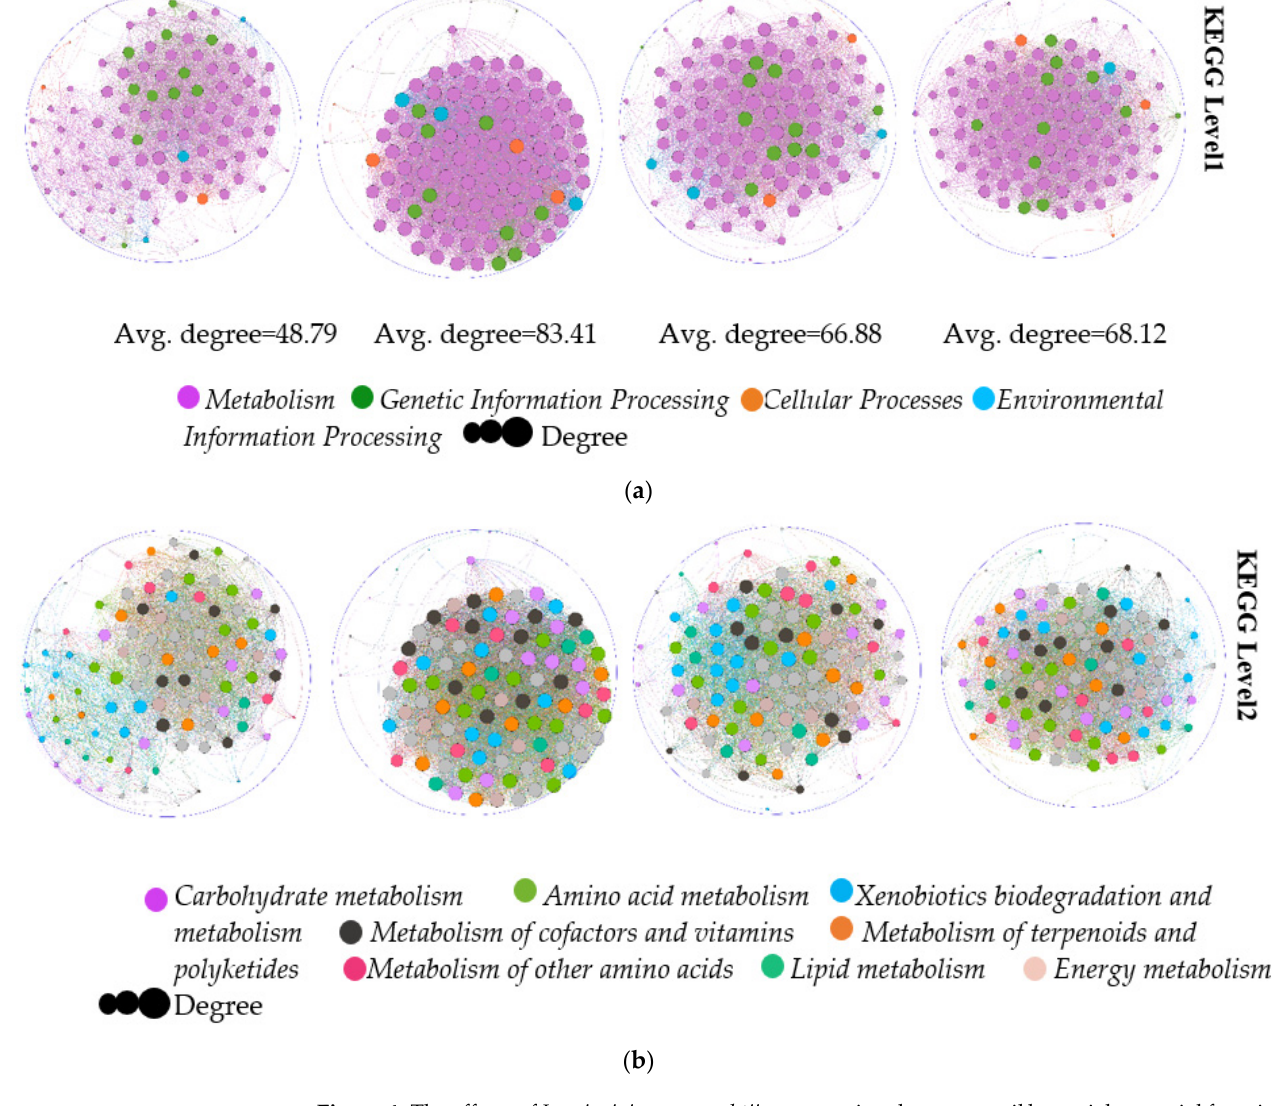
Figure 4. The effects of L. principis − rupprechtii regeneration degree on soil bacterial potential functions. ( a , b ) Variation in core soil microbial community functions associated with L. principis − rupprechtii regeneration degrees. Functions are based on KEGG annotations. The area of the node is proportional to the node degree, which is calculated from correlations of abundances for each KEGG pathway. Only correlations with an r of >0.6 or, < − 0.6 and a p value of <0.05 were included in the network.